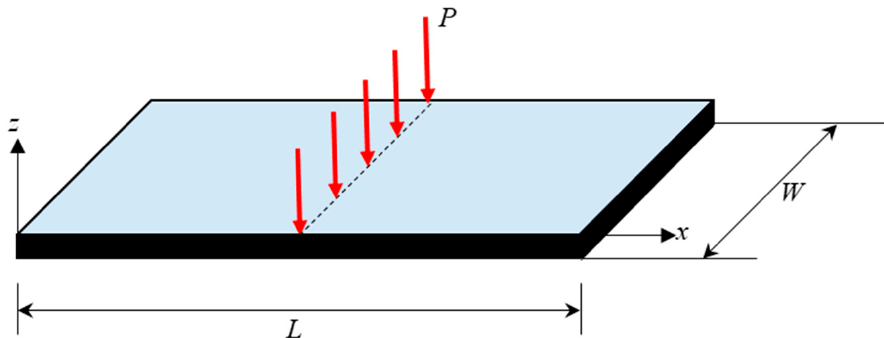
Figure 7. Fully clamped functionally graded Mindlin plate.